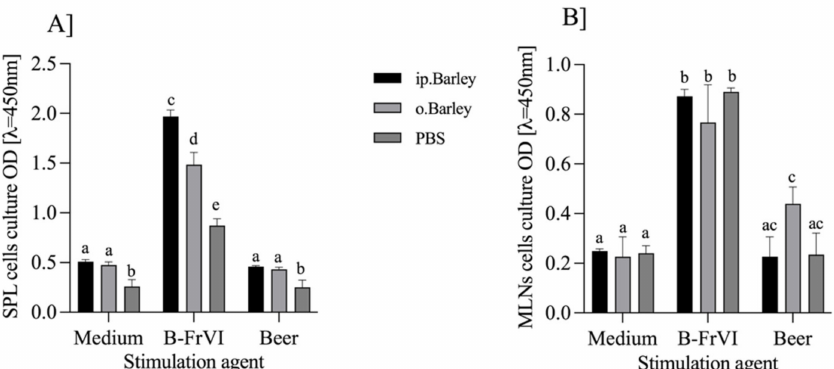
Figure 6. The ( A ) proliferation assays of splenocytes and ( B ) mesenteric lymph node lymphocytes after stimulation with B-FrVI, beer liophylisate (Beer), or growing in medium only (Con). Two-way ANOVA with Tukey’s test was used to determine the statistical differences. Bars represent the mean of the group (n = 5) ± SD. The mean values with different superscripts were different at p <